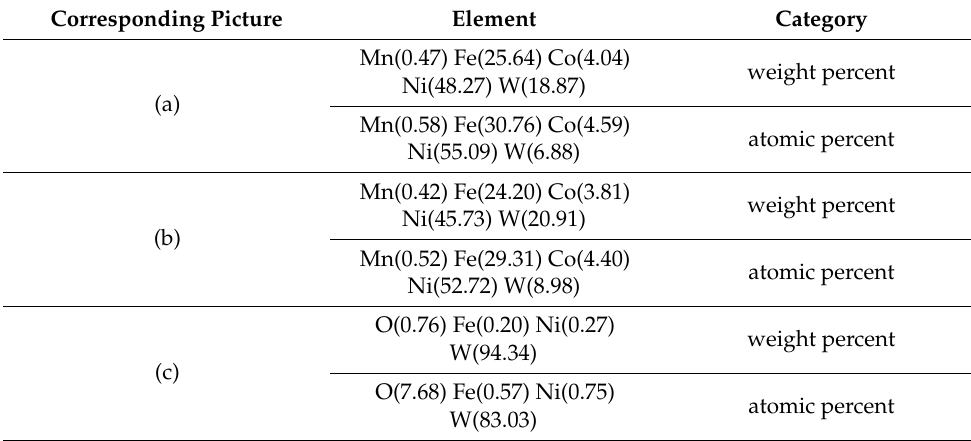
Table 4. The corresponding percentages of each element in Figure 7.